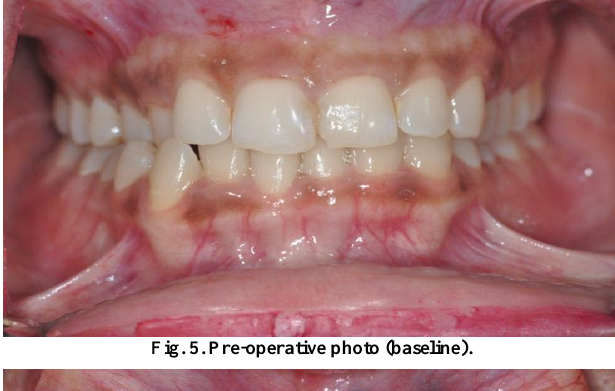
Fig. 6. Immediately after depigmentation.